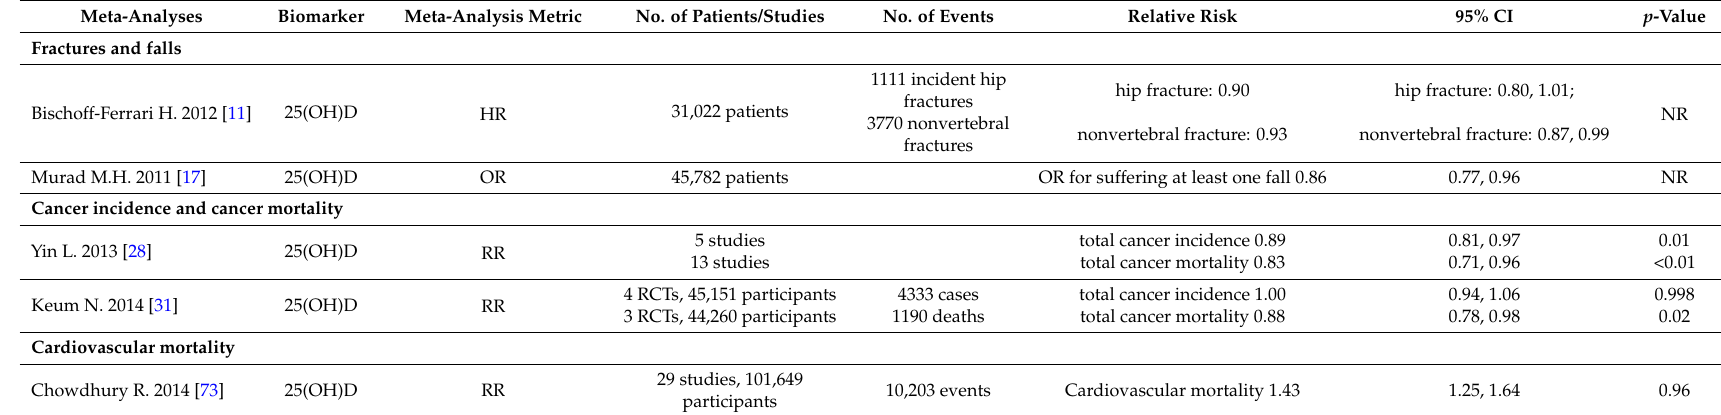
Table 1. Overview of selected recent meta-analyses of vitamin D status or supplementation and health outcomes (i.e., fractures and falls, cancer incidence and mortality, cardiovascular